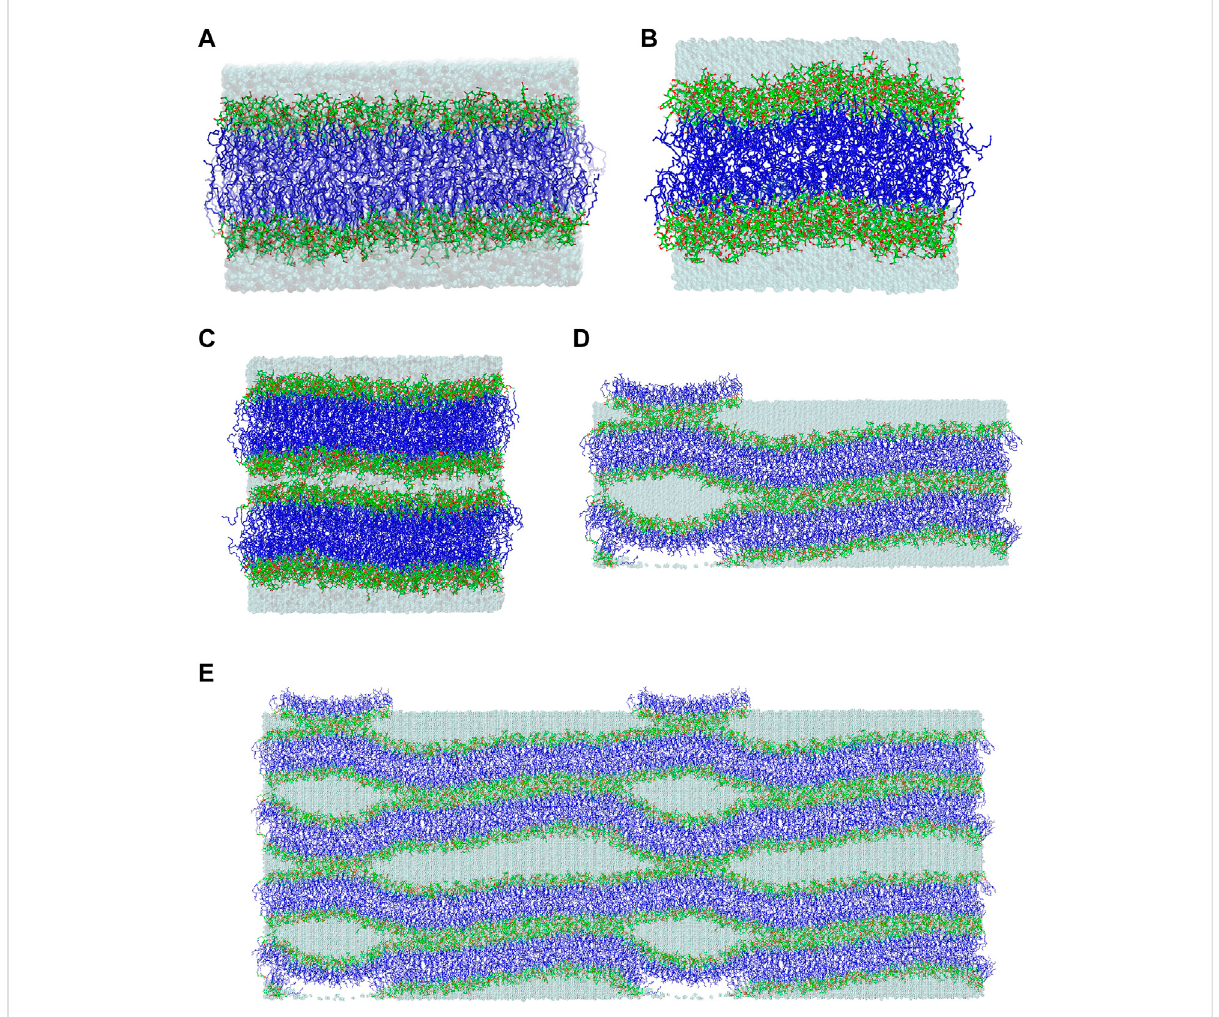
FIGURE 2 Final structures of the (A) MGDG and (B) DGDG bilayers after 320 and 1,050 ns of MD simulations, respectively. (C) Initial and (D) fi nal (after ~1,800 ns of MD simulation) structures of the double MGDG bilayer (W15). (E) The image of W15 in (D) was replicated along the x - and z -axis over periodicboundaries.Theatomsarerepresentedinstandardcolours,exceptforacylchaincarbonatoms,whicharedark blue .Thewaterisshownasa transparent blue surface. The hydrogen atoms are not